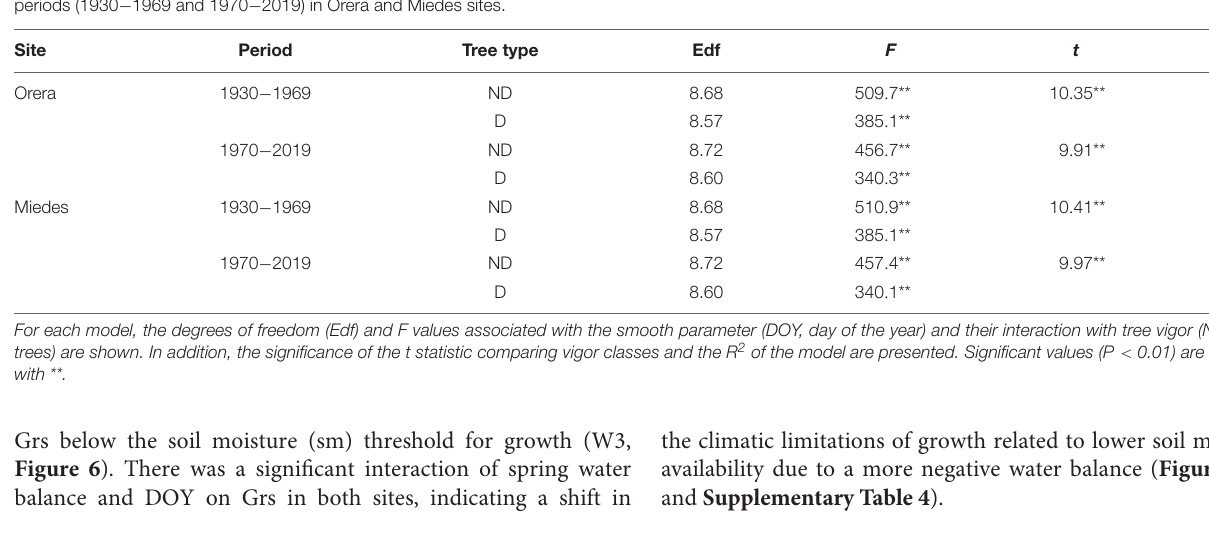
FIGURE 4 | Simulated Grs of the VS model obtained by relating daily climate data and mean series of RWI of D and ND trees in the (A) Orera and (B) Miedes study sites considering the periods 1930–1969 and 1970–2019. The daily Gr values are means ± SD. TABLE 4 | Results of the generalized additive mixed models (GAMMs) fitted to study the simulated growth variability (Gr) in P. pinaster D and ND in two consecutive periods (1930 − 1969 and 1970 − 2019) in Orera and Miedes